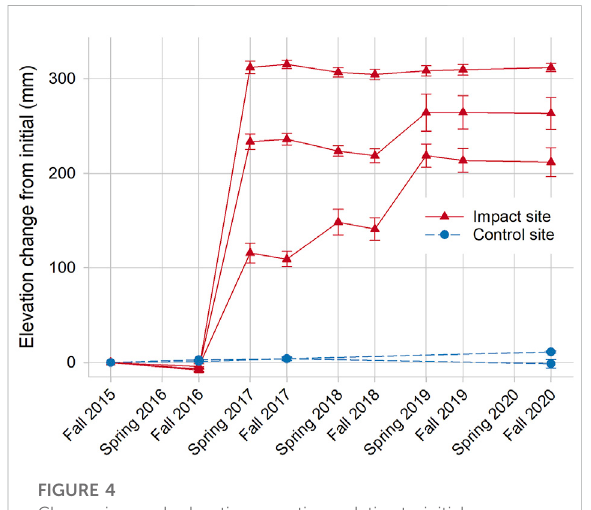
FIGURE 4 Change in marsh elevation over time relative to initial conditions (fall 2015) from three SETs each in the impact and control marshes. Sediment placement occurred in winter after the fall 2016 measurements. Error bars are 1 SE.